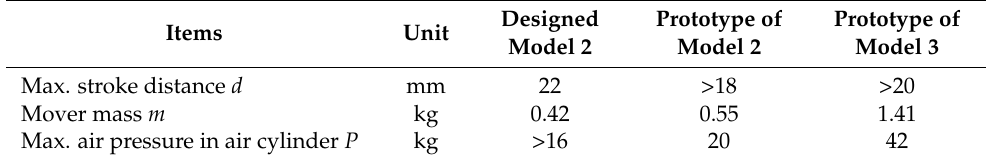
Table 3. Prototype experimental results and